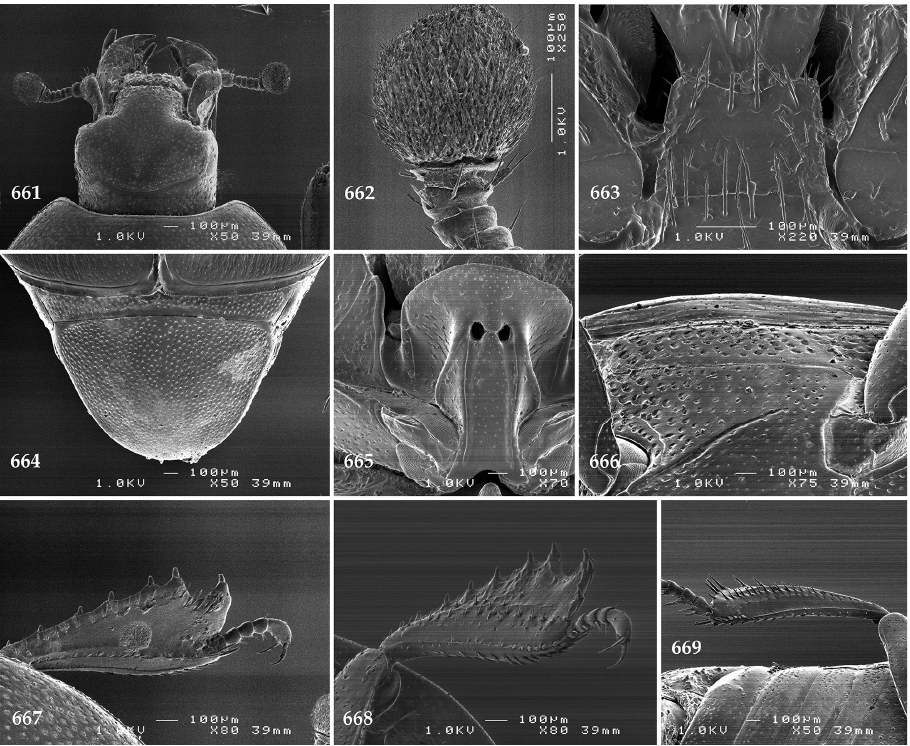
Figures 661–669. 661 Tomogenius kuscheli Dahlgren, 1976 head, dorsal view 662 antennal club,